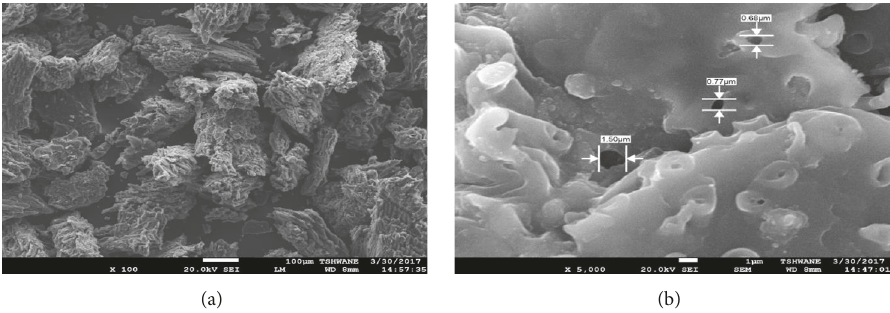
Figure 9: (a) Overview of 𝐵 3 from SEM analysis; (b) pore size distribution of 𝐵 3 at × 5000 magnification.